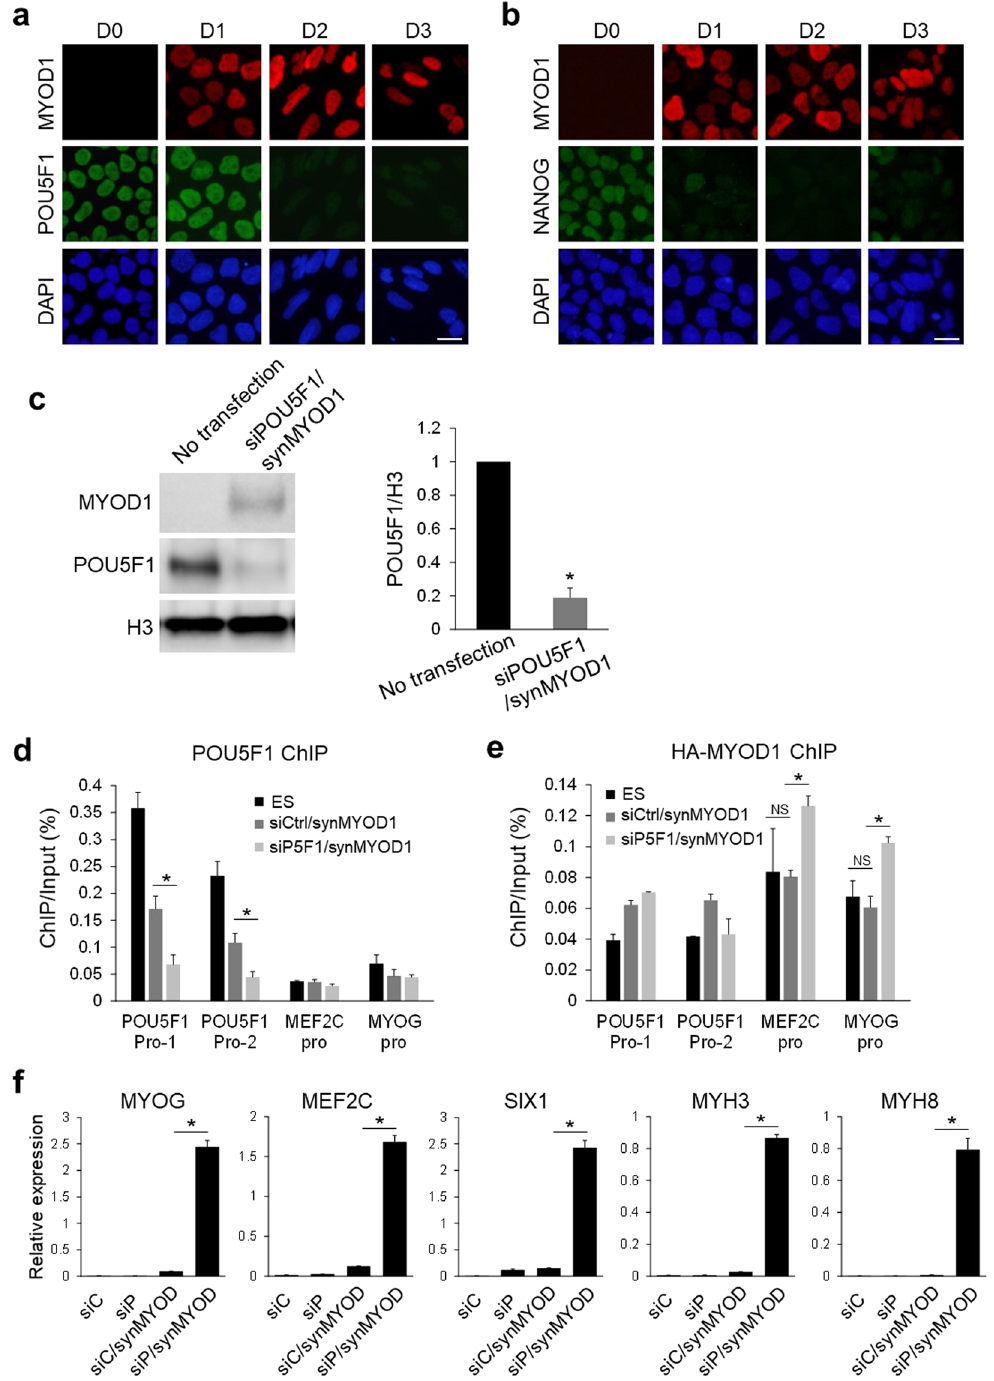
Figure 2. POU5F1 knockdown facilitates synMYOD1-induced myogenic gene activation. ( a ) Immunostaining analysis for POU5F1 in the siPOU5F1 and synMYOD1 (siPOU5F1/synMYOD1)-transfected cells at day 0 to day 3 post transfection. MYOD1 was detected by the specific antibody. Nuclei were stained with DAPI. Scale bar: 10 μ m. ( b ) Immunostaining analysis for NANOG in the siPOU5F1/synMYOD1-transfected cells at day 0 to day 3 post transfection. MYOD1 was detected by the specific antibody. Nuclei were stained with DAPI. Scale bar: 10 μ m. ( c ) Immunoblotting analysis for POU5F1 in the siPOU5F1/synMYOD1-transfected cells at day 3 post transfection. MYOD1 was detected by the specific antibody. The H3 antibody was used as a loading control. The relative intensities of POU5F1 signals normalized by H3 were compared between no transfection and siPOU5F1/synMYOD1 transfection (mean ± SEM from three independent biological replicates). * P < 0.01, t-test. ( d ) ChIP analysis showing POU5F1 enrichment at the promoter regions (Pro-1 and Pro-2) of POU5F1 in hESCs, siControl/synMYOD1-treated cells, and siPOU5F1/synMYOD1-treated cells. The promoter regions of MEF2C and MYOG were used as negative controls. The error bars indicate the SEM from three